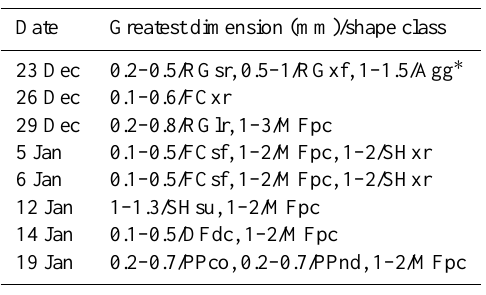
Table 3. Classification of size and shape of the observed surface snow particles according to Fierz et al. (2009). See Sect. 2.3 for explanation of the shape codes.